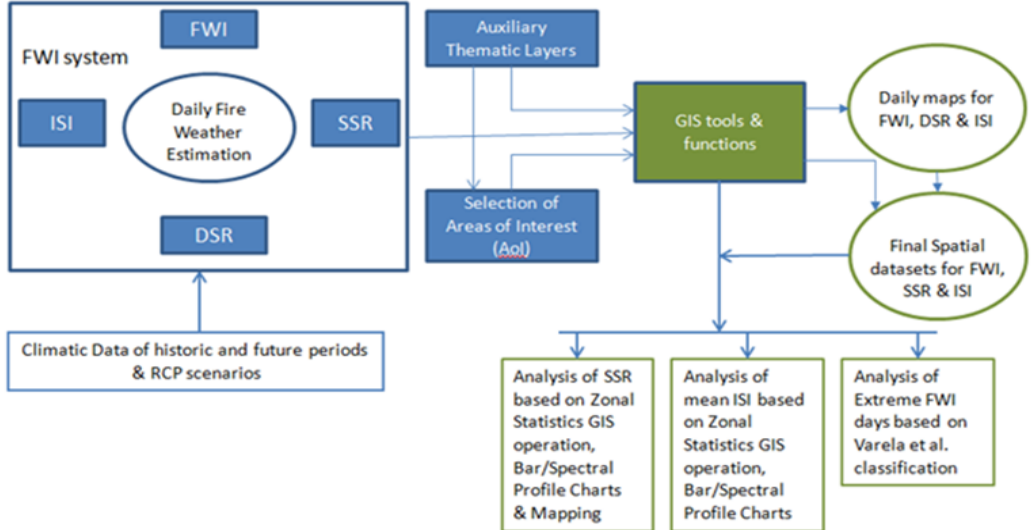
Figure 1. Flow process of the developed methodology for the derivation of fire weather patterns for selected Areas of Interest (FWI—Fire Weather Index, ISI—Initial Spread Index, DSR—Daily Severity Rating, SSR—Seasonal Severity Rating, RCP—Representative Concentration Pathway, GIS—Geographic Information System).